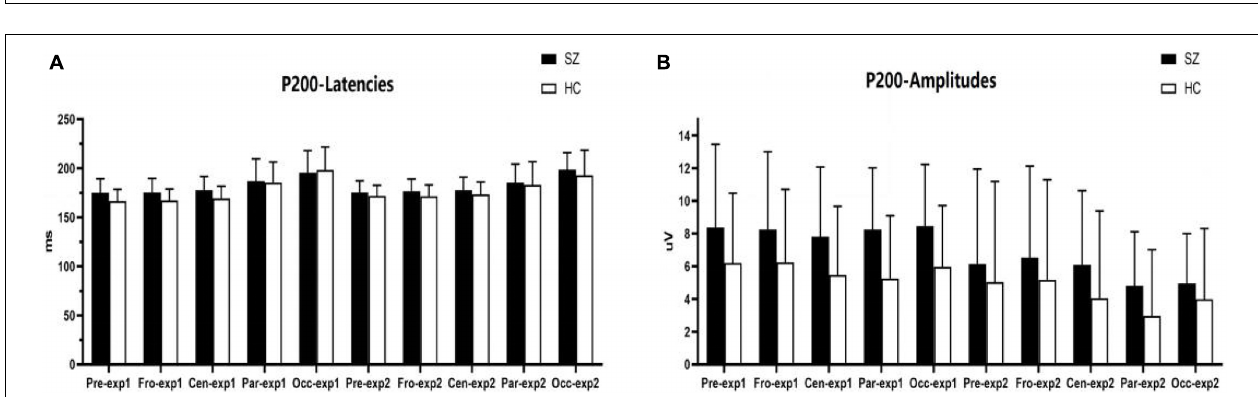
FIGURE 3 | Comparisons of N100 latencies (A) and amplitudes (B) between the schizophrenia group and HC group within ROIs and experiments. SZ, schizophrenia; HC, healthy control; exp, experiment; Pre, prefrontal, Fro, frontal, Cen, central, Par, parietal, Occ, occipital.